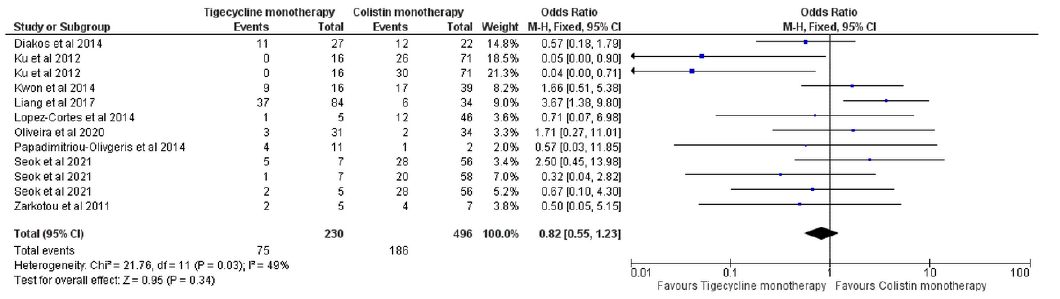
Figure 3. Overall mortality of tigecycline monotherapy versus colistin monotherapy [7,12,14– 17,19,23,24].